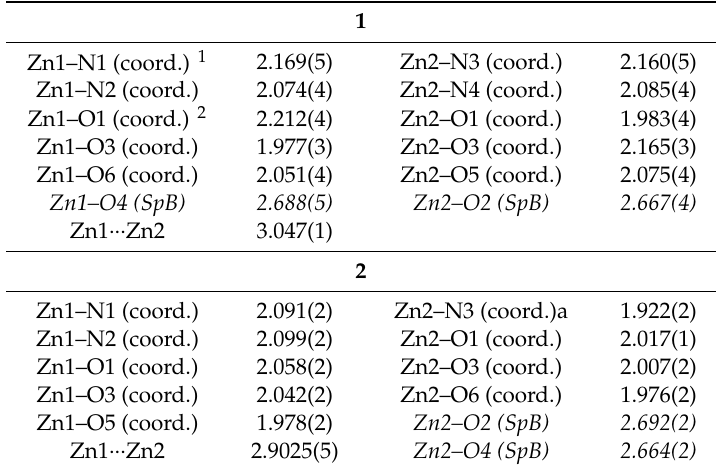
Table 1. Selected bond lengths (Å) in compounds 1 and 2 .